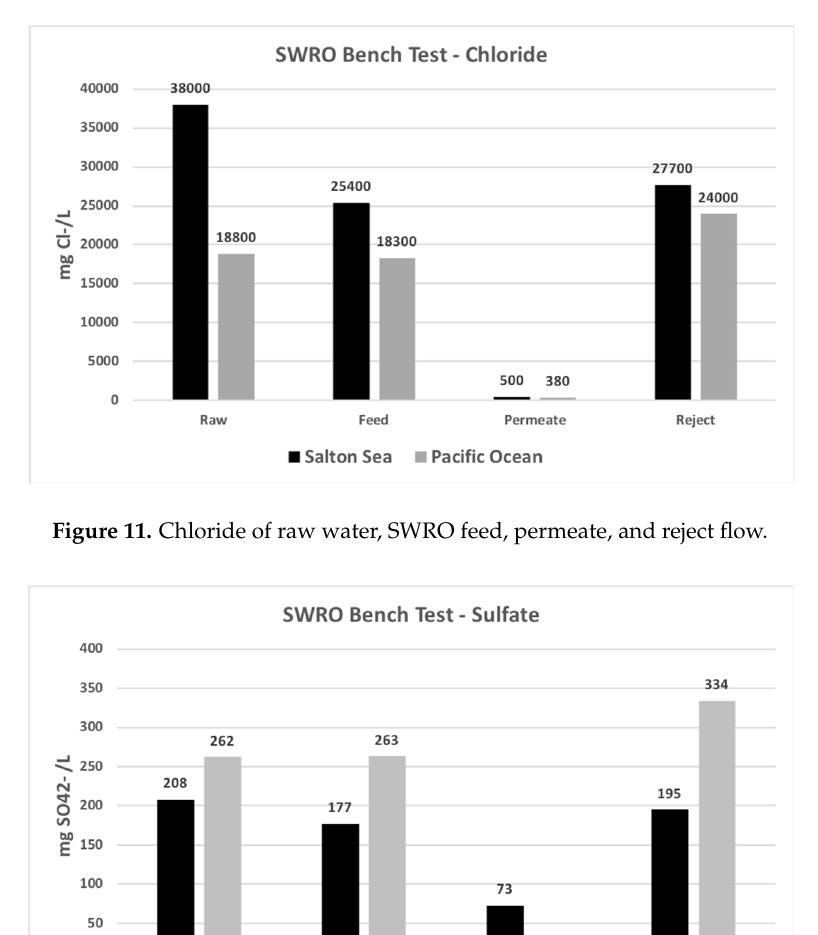
Figure 10. Total dissolved solids (TDS) of raw water, SWRO feed, permeate, and reject flow. TDS = total solids − suspended solids. Water 2018 , 10 , x FOR PEER REVIEW